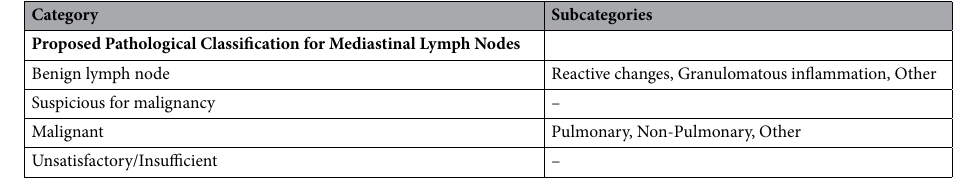
Table 4. Proposed pathological classification with four main categories and six